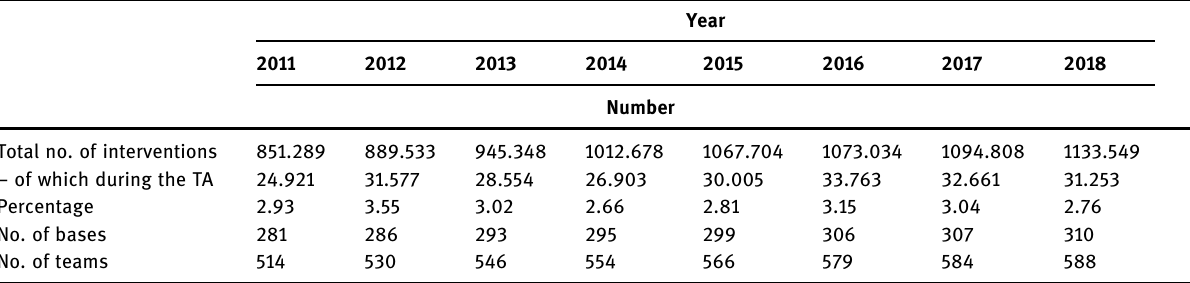
Table 4: The number of interventions of the Emergency Medical Services, interventions during the TA, number of bases of emergency services and numbers of emergency teams between 2011 and